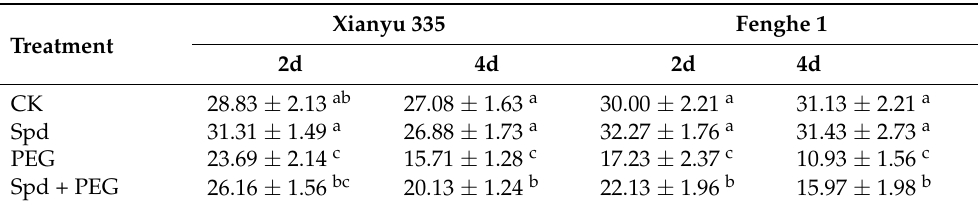
Table 1. Effects of exogenous spermidine on NO 3 − concentration in xylem bleeding sap of maize seedlings under drought stress ( µ g L − 1